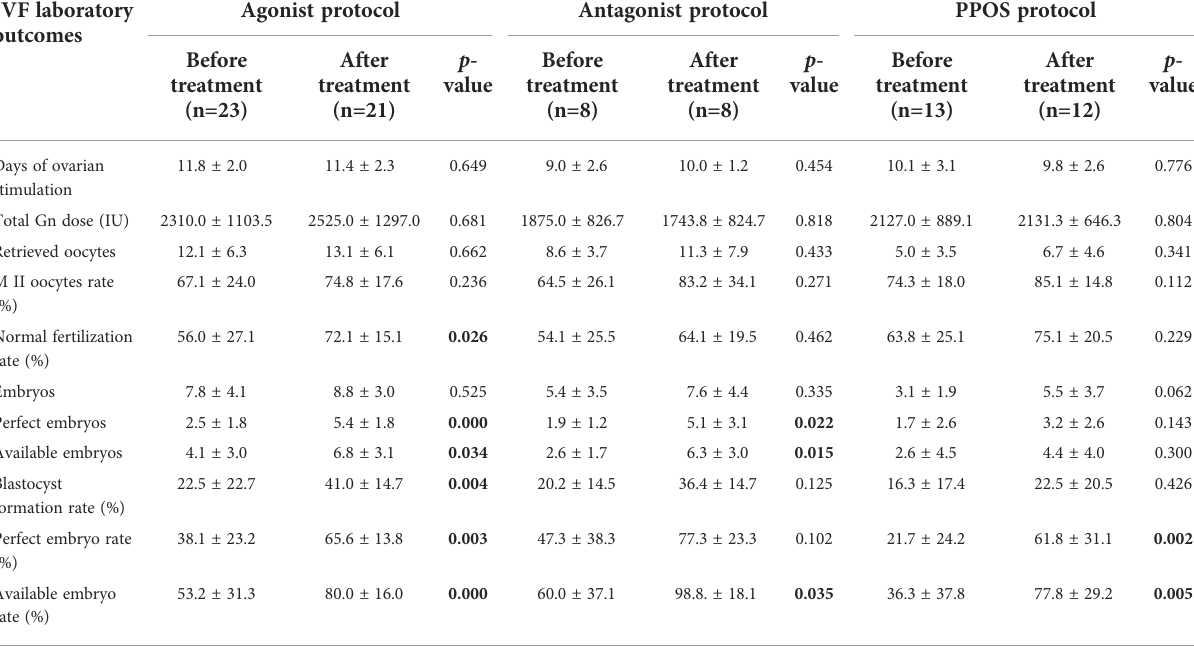
TABLE 3 Reproductive outcomes of IVF cycles in aPL positive women before and after hydroxychloroquine and antiplatelets treatment.